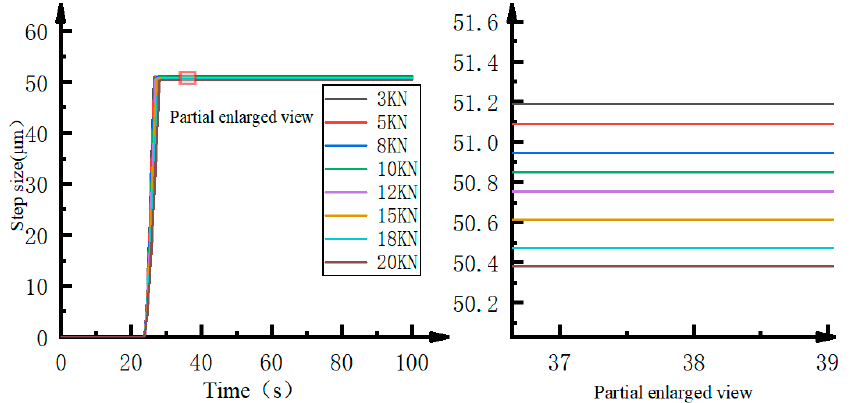
Figure 7. Single-step step characteristics of the improved stepper drive.